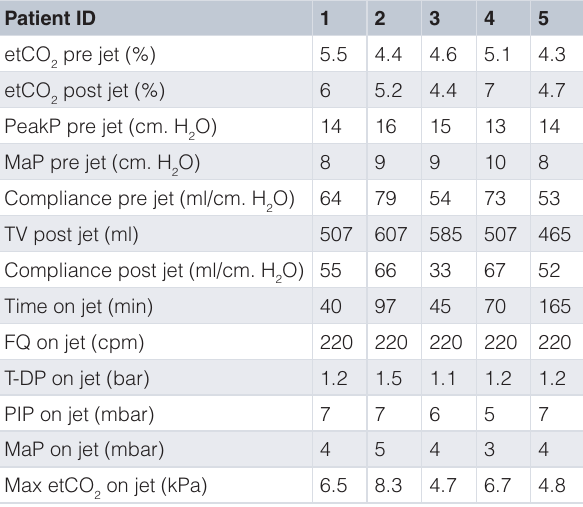
Table 2. Ventilator settings and